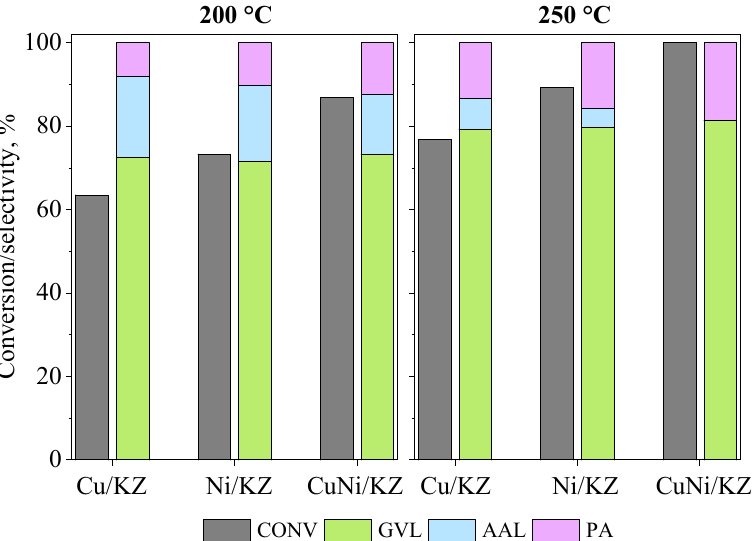
Figure 9. LA conversion and product distribution over Cu-KZ, Ni-KZ, and CuNi-KZ catalysts at different reaction temperatures.